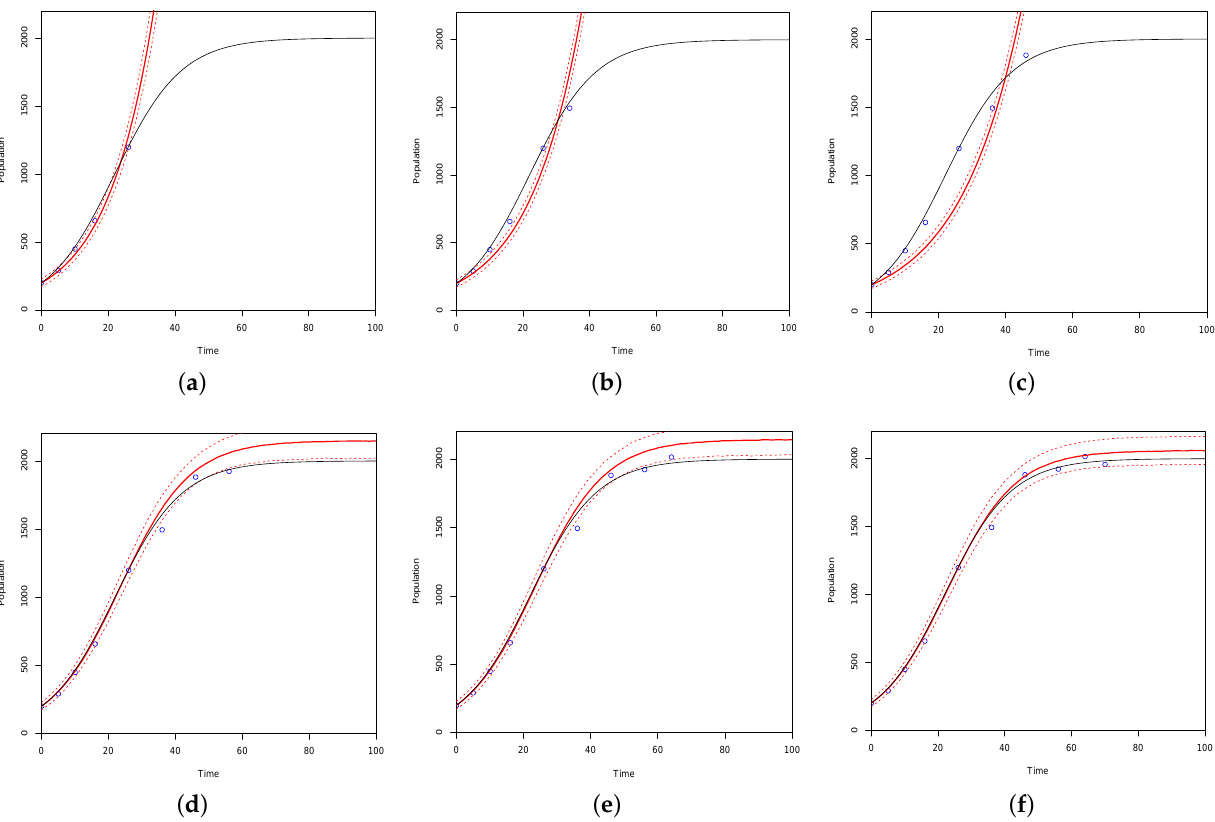
Figure 3. The fifth design point is selected in panel ( a ) found in a window following the design from Figure 2: panel ( b ). Panels ( b – f ) represent each additional design point added until the budget of ten points is exhausted. Each panel plots the ground truth model in black, the design points in blue and fits the design with a red curve based on the parameter estimates. The red dotted lines represent the 2.5% and 97.5% prediction quantiles.